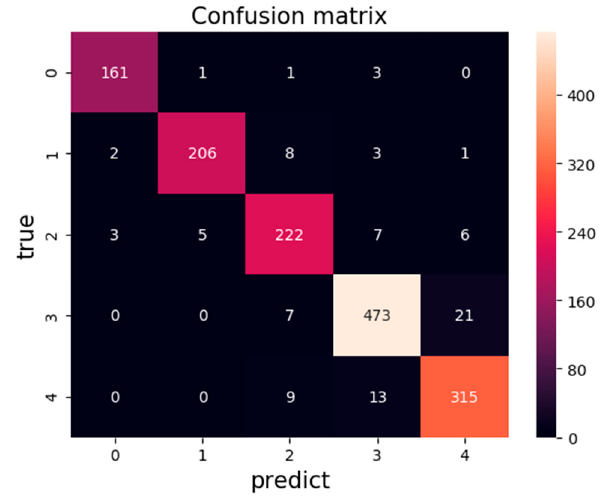
Figure 6. The confusion matrix of the proposed method.